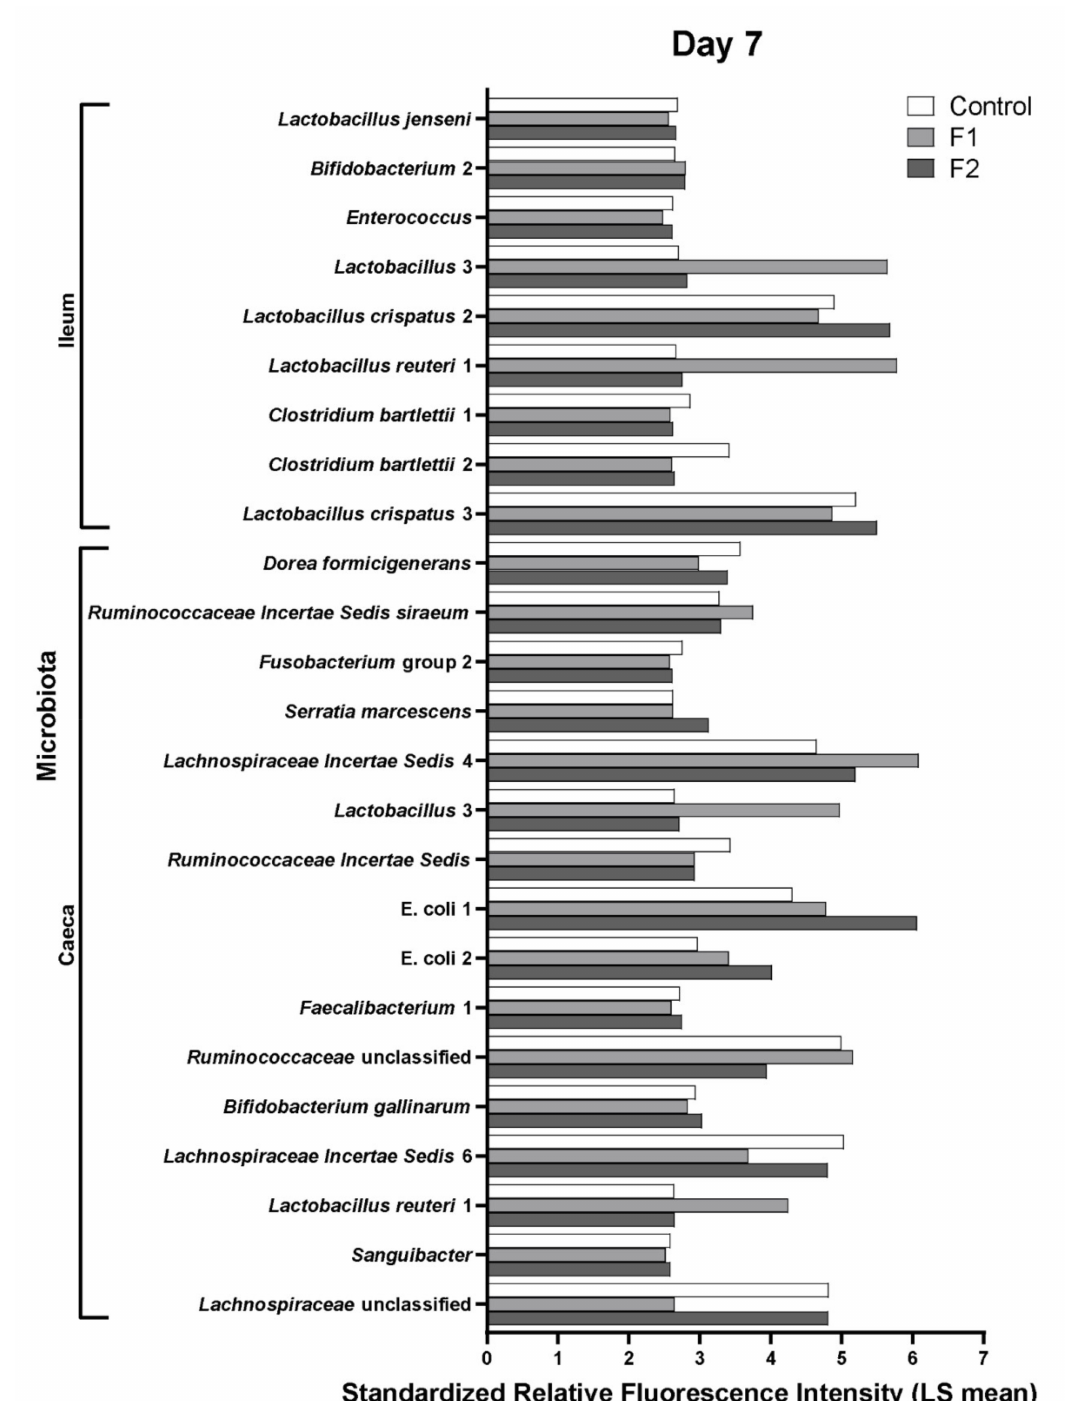
Figure 6. Relative abundance of intestinal microbial taxa significantly increased with the respective feed at day 7 in broiler chickens. Standardized relative fluorescence intensities (LS means) of the microbial taxa in the ileum and ceca as measured by the microarray (Table 2) that were significantly higher with standard diet (control), feed supplemented with glucose oligosaccharide (F1), or long-chain glucomannan (F2) at day 7 in broiler chickens. LS mean per microbial target and diet group are shown ( n = 5) with statistical significance of FDR adjusted p -values set at <